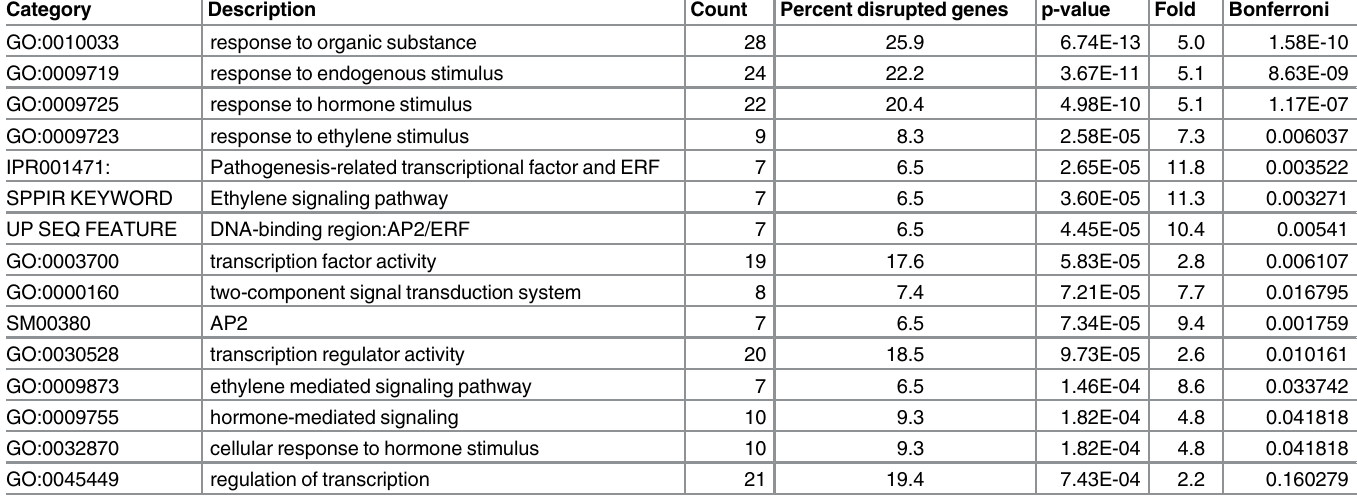
Table 1. Functional clustering of genes disrupted (less than 0.5-fold expression or more than 1.5-fold expression) by BPA treatment. Analysis by DAVID.